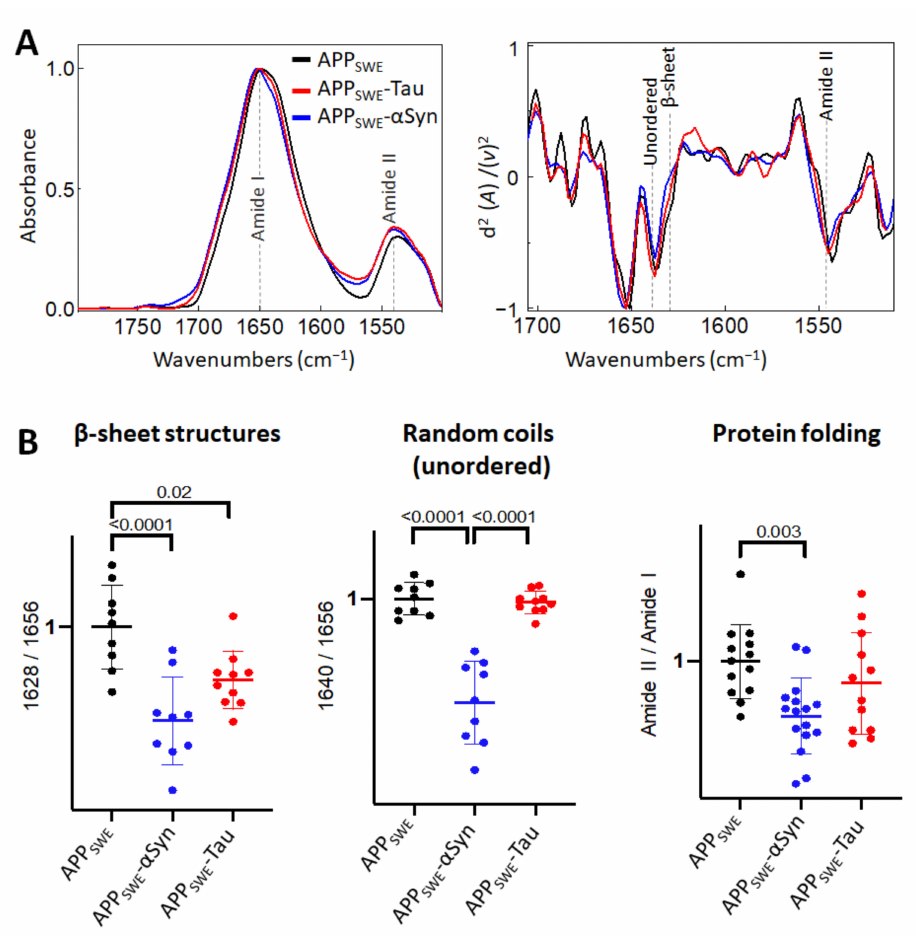
Figure 5. Comparison of structural changes in protein aggregates in the bigenic models of AD protein aggregation. ( A ) Averaged and normalized infrared absorbance spectra and corresponding normalized second derivatives of N2a- APP SWE , N2a-APP SWE - α Syn, and N2a-APP SWE -Tau, models of mixed protein aggregation. Numbers in parentheses indicate corresponding graphs with statistical analysis. Dashed lines indicate peak positions. ( B ) Statistical analysis of structural changes: one-way ANOVA ( p < 0.01) ± s.d. All values were normalized to the control, N2a-APP SWE cells. One dot corresponds to a single cell, n = 7–20 cells per independent measurement reproduced at least